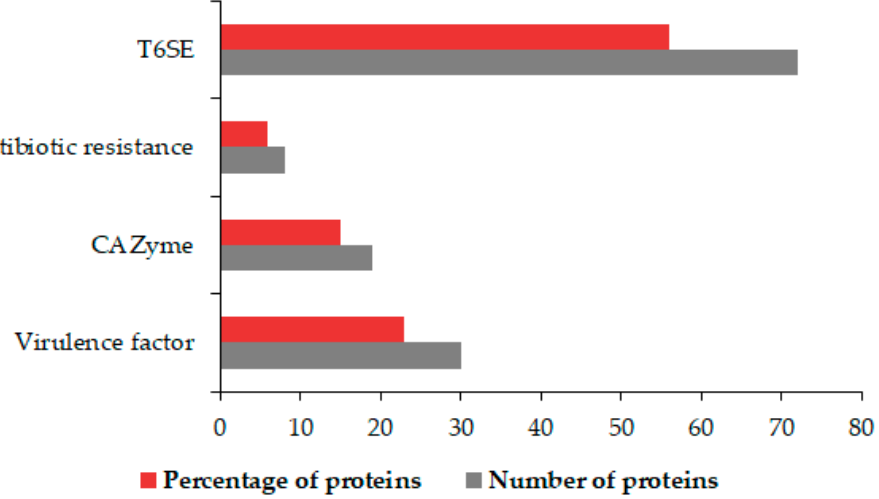
Figure 6. OMV proteins associated with virulence, carbohydrate metabolism, stress resistance, and competition. The graph shows the number and percentages of OMV virulence factors, CAZymes, antibiotic resistance agents, and T6SE.